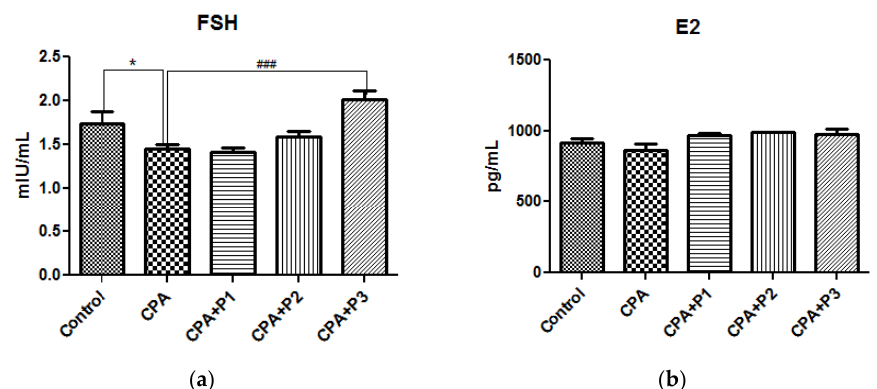
Figure 3. Sex hormone levels in serum — ( a ) FSH and ( b ) E2 of Control, CPA, and CPA + P1/P2/P3 exposed animals. Data represent mean ± SEM; One-way ANOVA followed by Bonferroni’s Multiple comparison test; * Significant at p < 0.05 — compared with Control group; ### p < 0.001 — compared with CPA group.